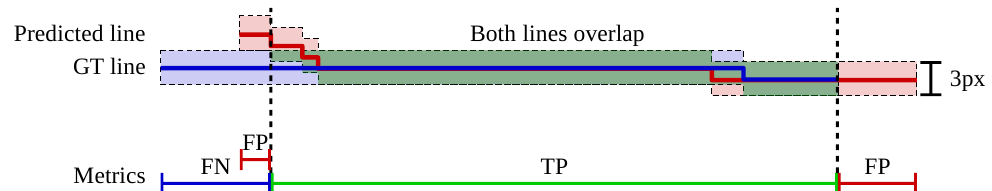
Figure 11. Visualisation of the metric used to evaluate the staff line detection. The blue and red solid lines in the upper image denote the GT and prediction of a single staff line, respectively. The colored area is the allowed space of 3 px where lines must overlap to be counted as a match. If at least one vertical pixel is green it is counted as correct. The bottom line shows the intervals which are counted as false negative (FN), true positive (TP) and false positive (FP). The deviation in the first part counts both as FN and FP.